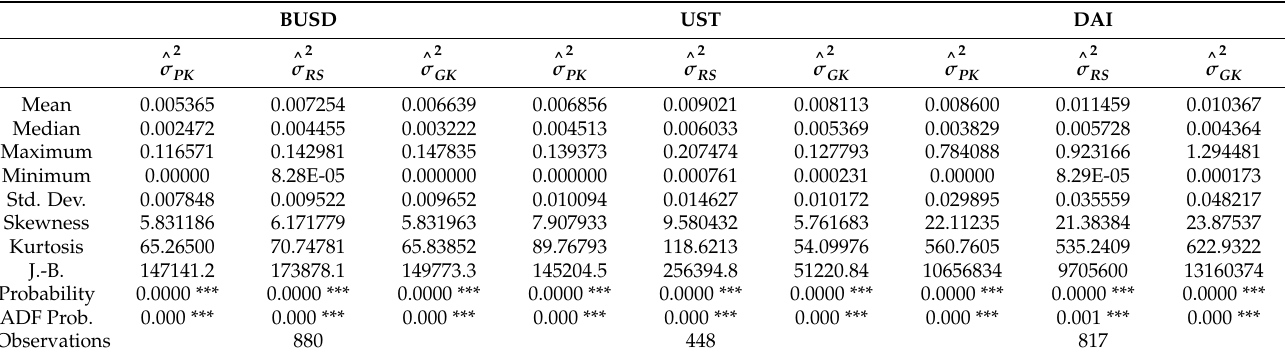
Table 2. Cont . BUSD